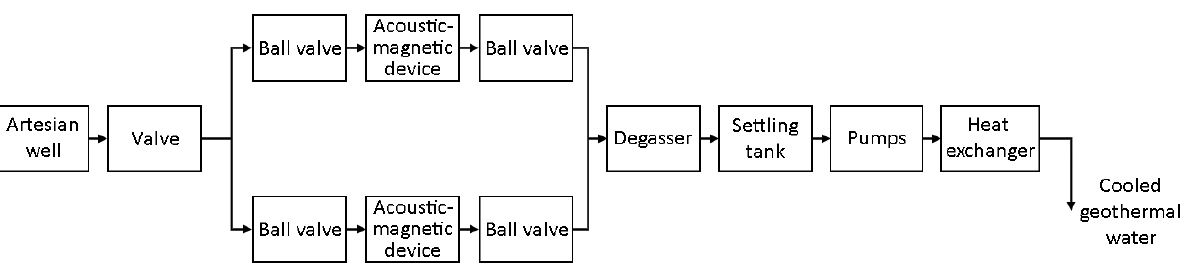
Figure 2. Functional scheme of a geothermal heat supply system for greenhouses with a surface heat exchanger.